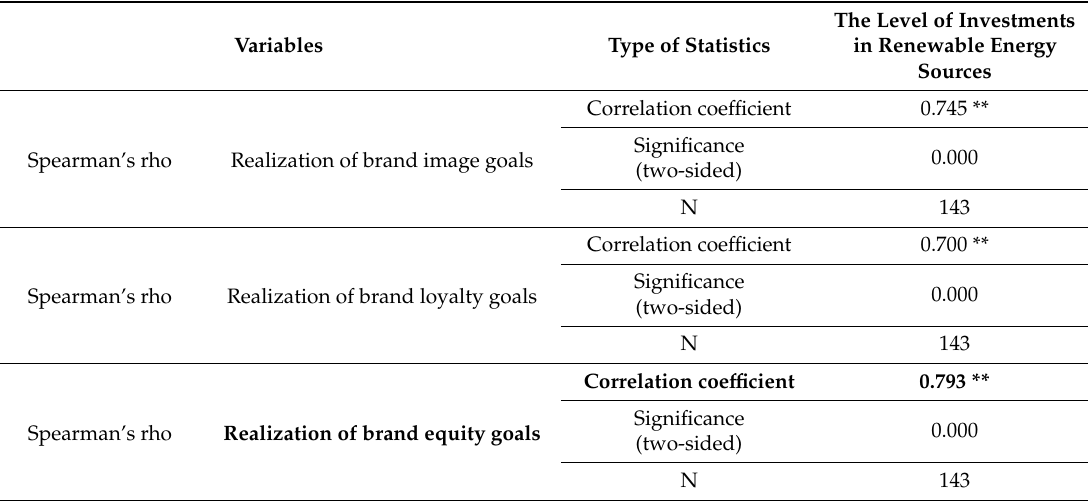
Table 7. Correlation between the level of investments in renewable energy sources and the realization of brand equity